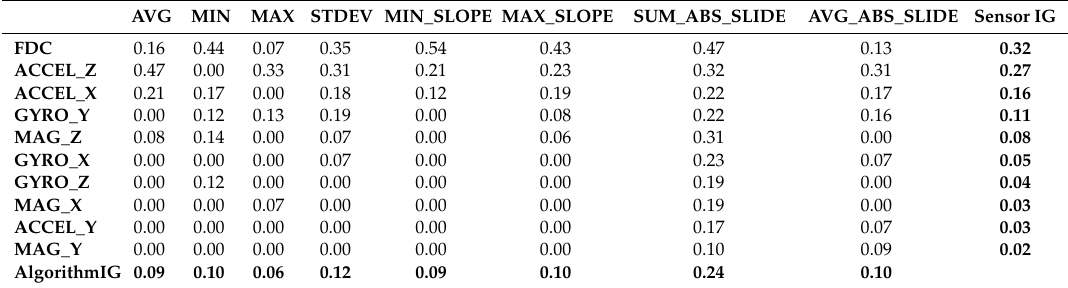
Table A1. Measures the percentage of total information that the model gained from each feature. The last column shows the average information gained (IG) by each sensor. The last row shows the average information gained by each algorithm. This shows that the squeeze of the bottle provides the most information to distinguish classification, followed by the orientation of the